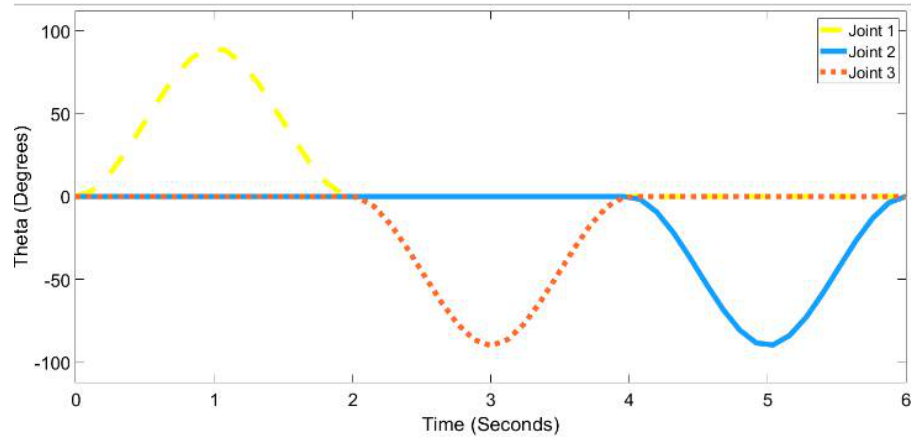
Figure 11. Input signals to the inverse dynamic model of SAMA. The dynamic torque scores of the three joints, based on the input trajectories, were calculated and are shown in Figure 12a–c. Hence, the static and dynamic torque require- ments were calculated for the subject in Equation (8). Table 5 shows the peak and root mean square (RMS) torque for each joint using a factor of safety (FS) = 1.1.